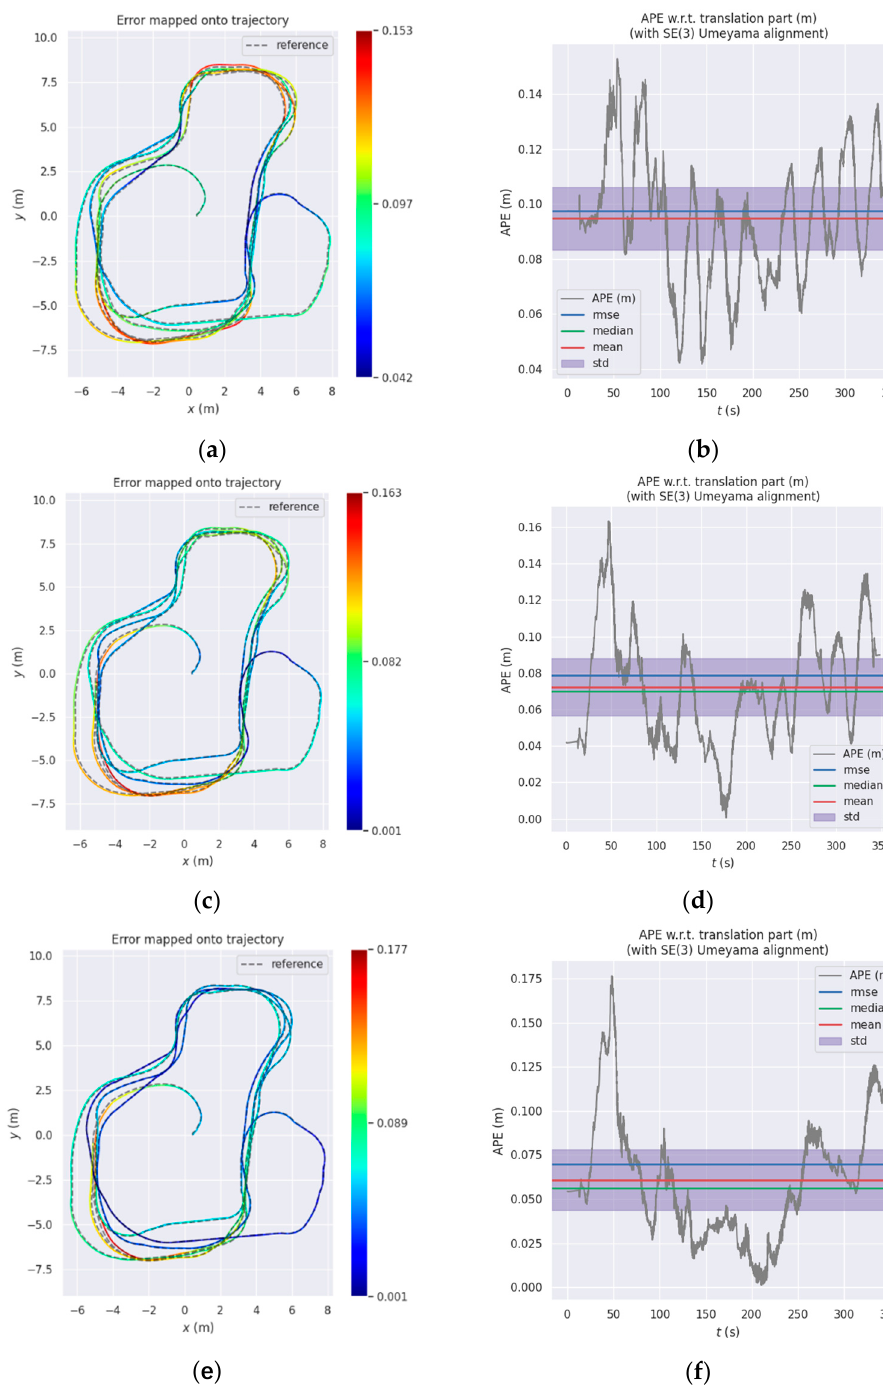
Figure 4. Comparison of the proposed method versus OpenVINS: ( a ) OpenVINS; ( c ) OpenVINS+IMU Pre-integration; ( e ) OpenVINS+IMU Pre-integration +Odom; ( b , d , f ) are the corresponding errors. Table 2. The Root Mean Square Error (RMSE) results of OpenVINS and the proposed algorithm. Evaluation